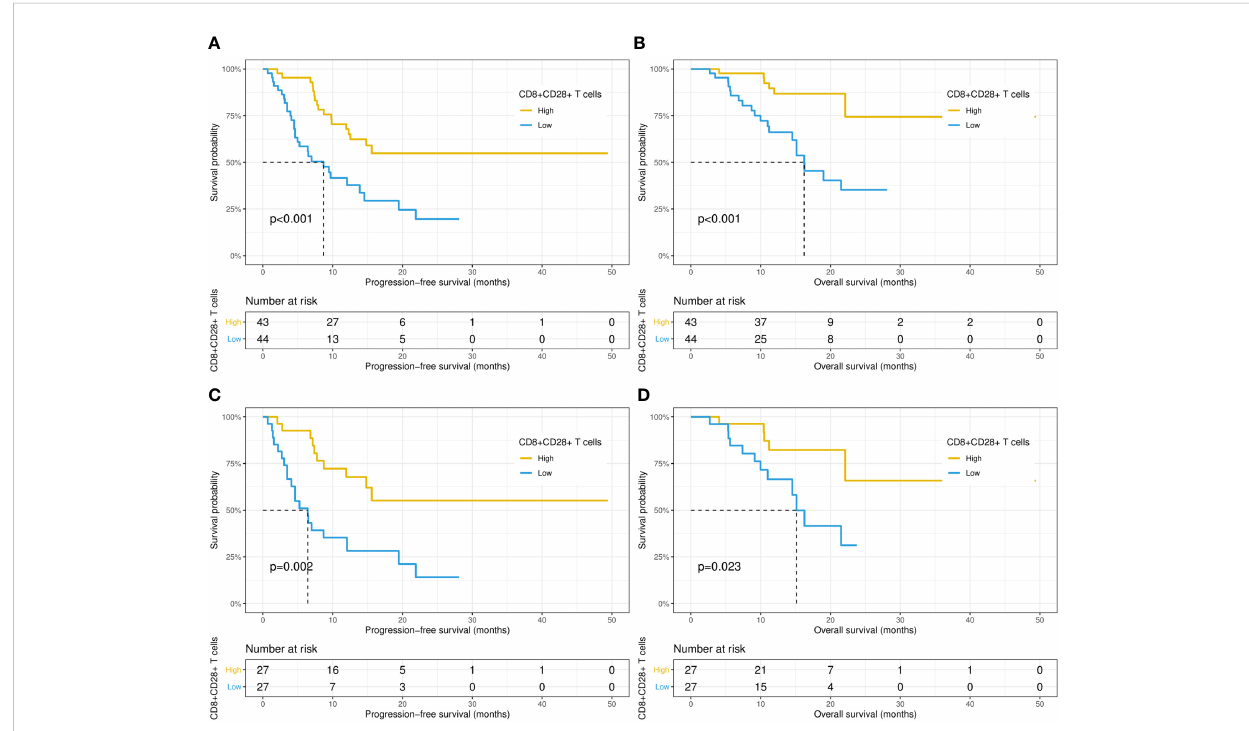
FIGURE 2 Kaplan − Meier curves of progression-free survival and overall survival in patients with high ( ≥ 190 cells/ m L) and low (< 190 cells/ m L) CD8+CD28+ T- cell counts before (A, B) and after (C, D) propensity score matching.